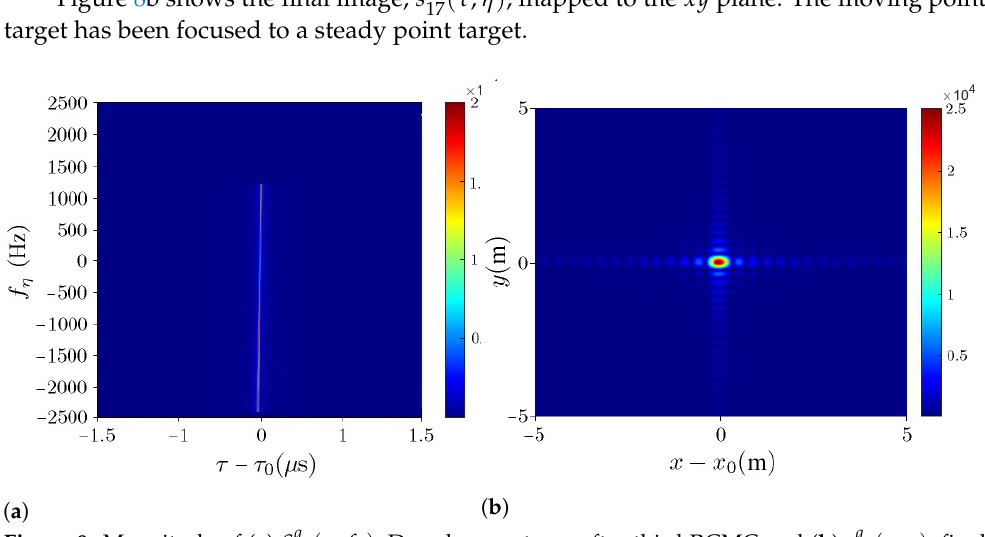
Figure 8. Magnitude of ( a ) S q SAR image mapped to xy plane.